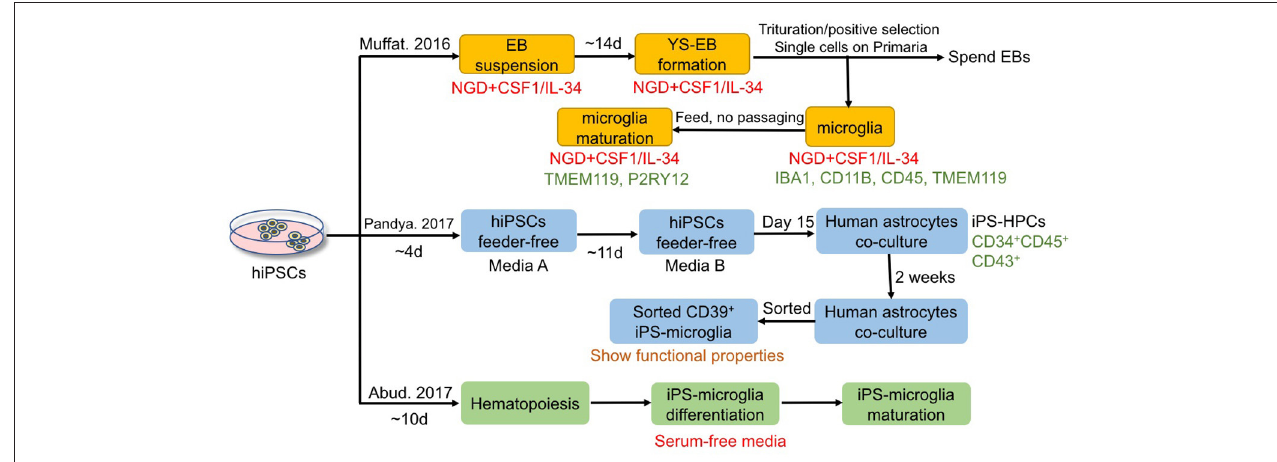
FIGURE 4 | Current approaches for deriving microglia from hiPSCs . Muffat et al. demonstrated that hiPSCs can be differentiated to microglia with neuroglial differentiation (NGD) media in the presence of CSF1 and IL-34, and the obtained cells possess the functions of phagocytes positive for microglial markers such as TMEM119 and P2RY12. Pandya et al. reported another method that applies co-culture with astrocytes for differentiation of hiPSCs to microglia-like cells via a hematopoietic progenitor-like intermediate stage. And Abud et al. established a fully defined and serum-free method to derive microglia-like cells from hiPSCs with robust scalability and high purity, via differentiating first toward hematopoiesis stem cells and then to